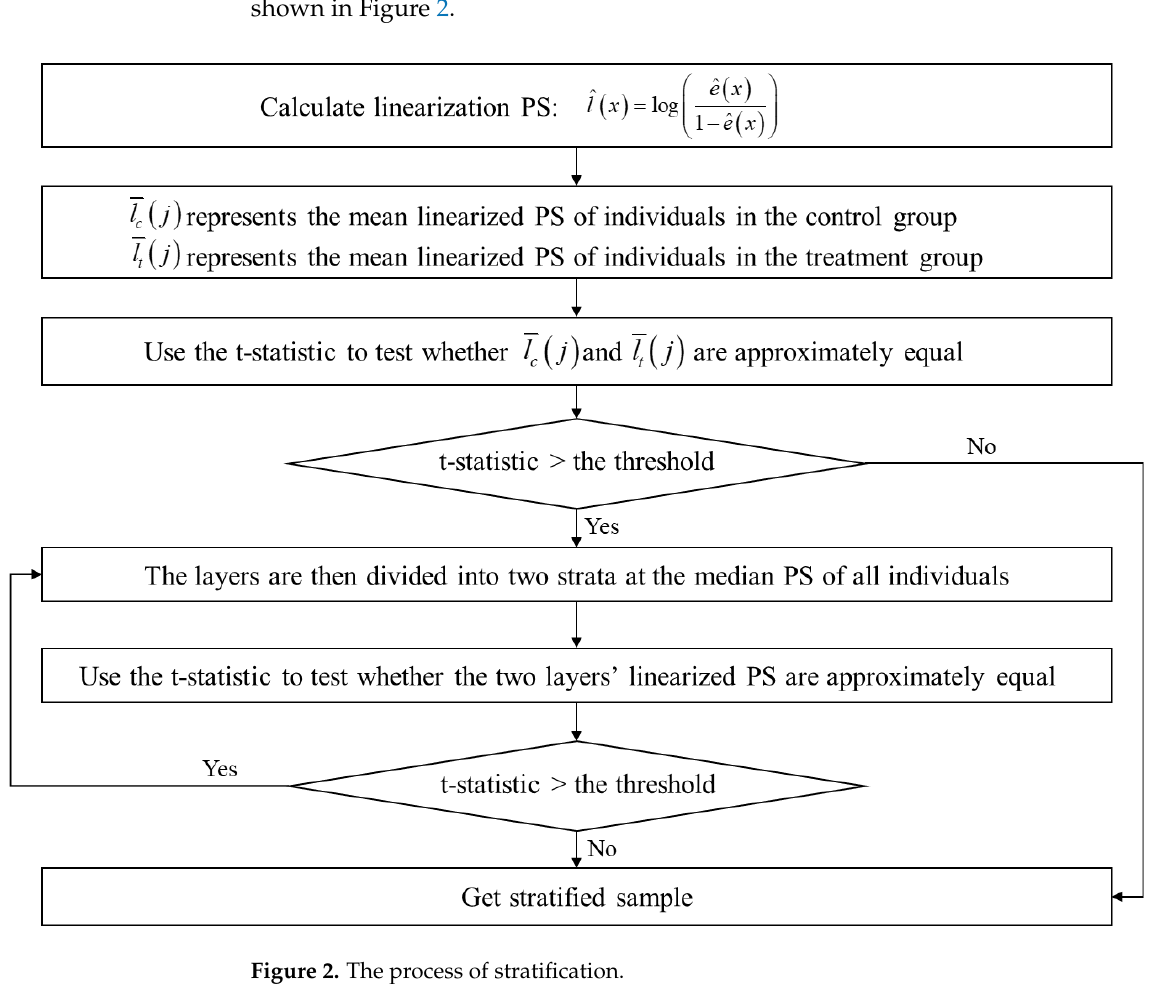
Figure 2. The process of stratification.